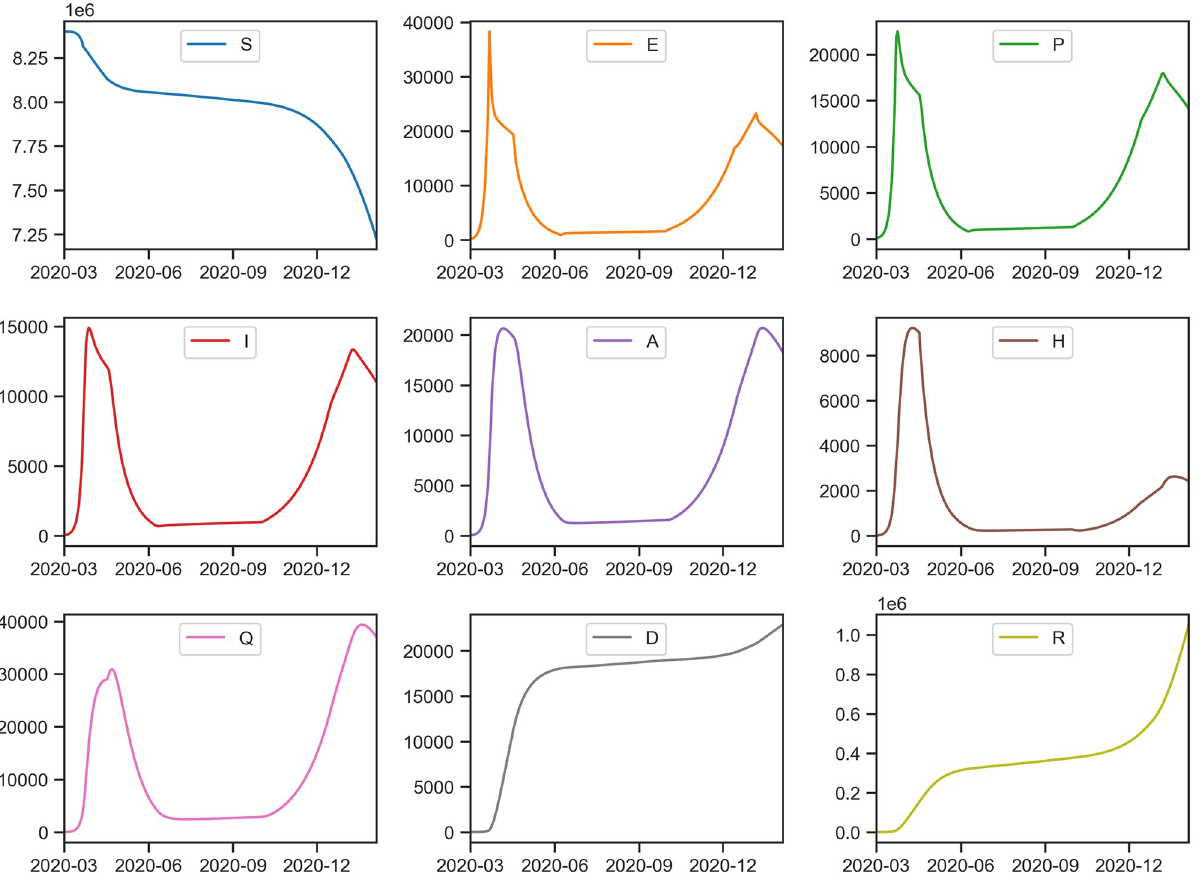
Fig 7. Estimation of the unobserved dynamics in all the model compartments ( S , E , P , I , A , H , Q , D , R ). The number of susceptible individuals ( S ) drops significantly as the number of cases hikes after December 2020.